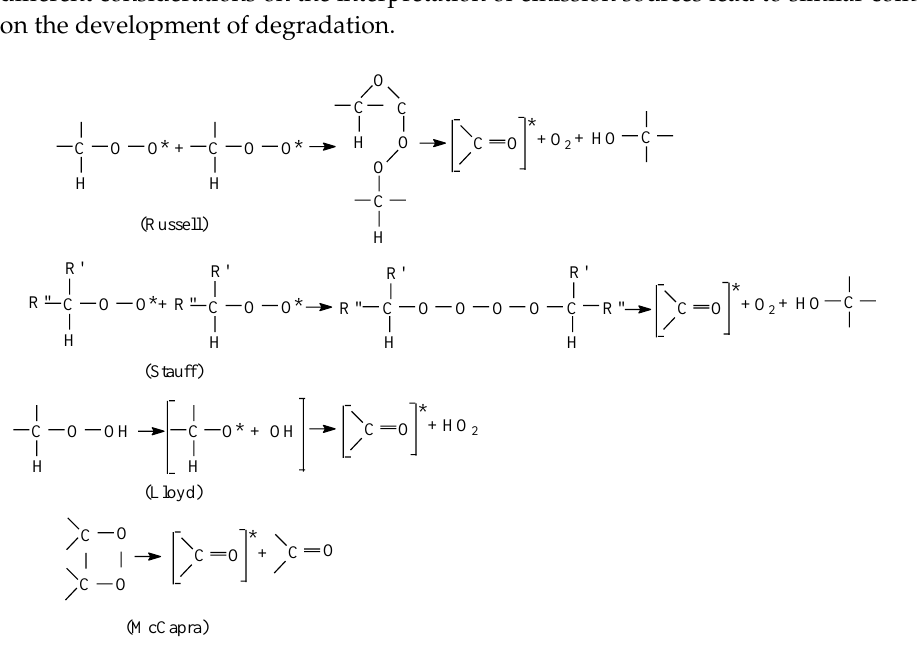
Figure 2. The mechanisms of chemiluminescence emission.